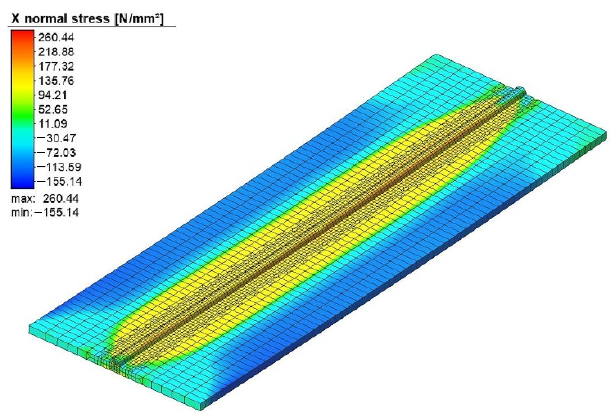
Figure 12. The residual stress at the optimum point.